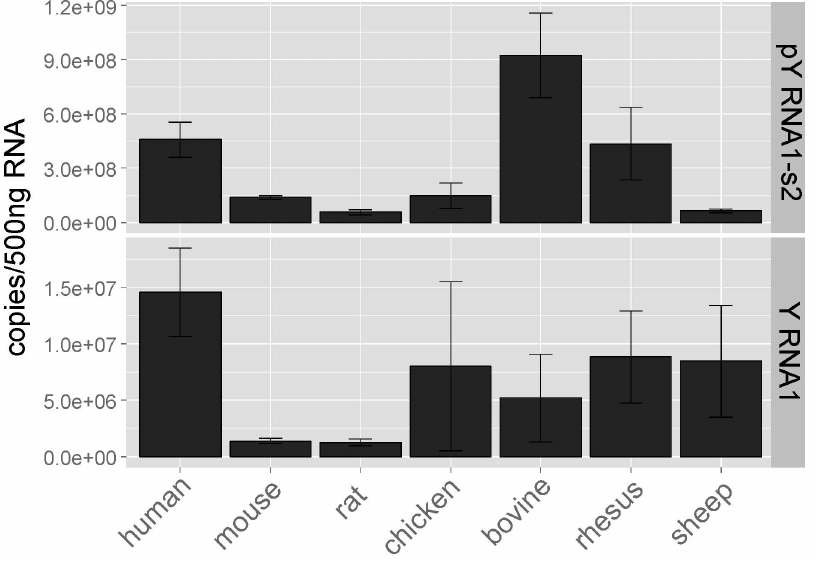
Figure 4. Presence of pY RNA1-s2 in mammalian and bird retinas. RNA was extracted from three retinas obtained from each of the indicated species; all samples were obtained during the day. Equal amounts of tissue were extracted using miRVana columns; cDNA libraries were created using the QuanitMiR system. The values are reported as copies of pY RNA1-s2/500 ng total RNA. It is apparent that the abundances of pY RNA1-s2 and of YRNA1 vary from species to species and that pY RNA1-s2 appears to be 50 to 100 times more abundant that Y RNA1, in all cases except the ovine retina. The Y RNA1 versus pY RNA1-s2 differences may reflect secondary structure differences which influence the efficiency of the RT reaction, resulting in greater amplification of pY RNA1-s2 over Y RNA1. Error bars are SEM.